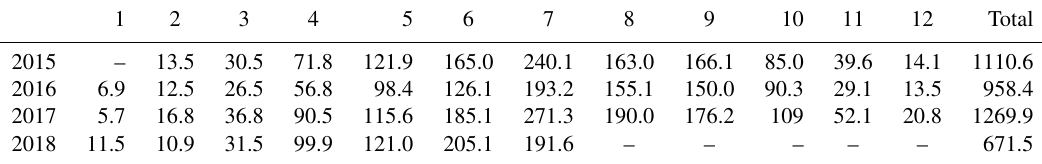
Table 2. Cumulative rainfall values of the Wobaoshi landslide (mm per